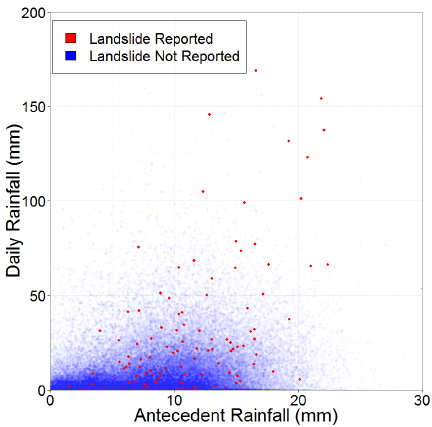
Figure 5. Scatter plot showing the distribution of landslides (red) and dates without recorded landslides (blue) comparing antecedent rainfall and daily